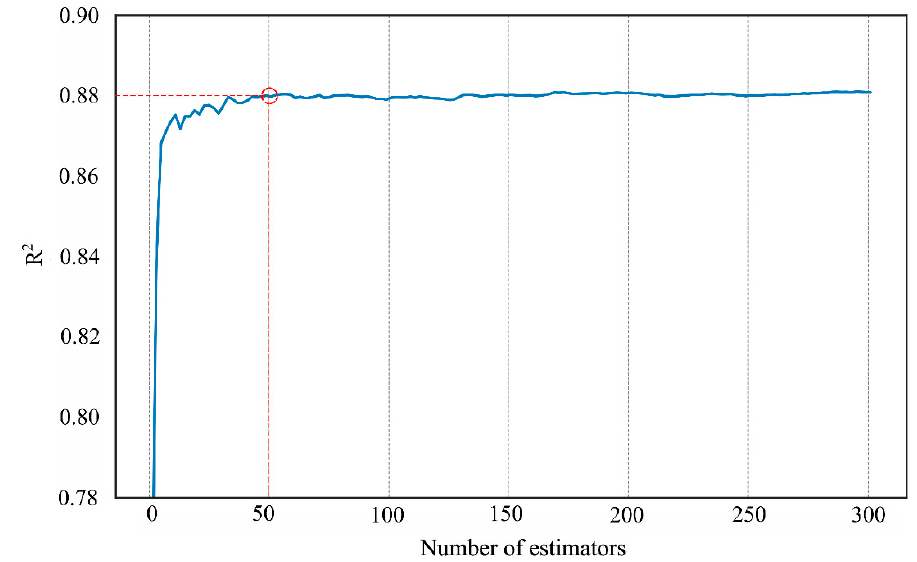
Figure 4. Relationship between model accuracy and the number of estimators.